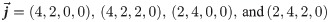
Statistics corresponding to conditions with j→=(4,2,0,0),(4,2,2,0),(2,4,0,0),and(2,4,2,0).